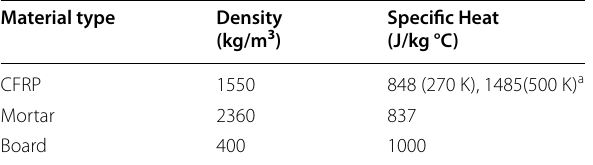
properties of materials at room